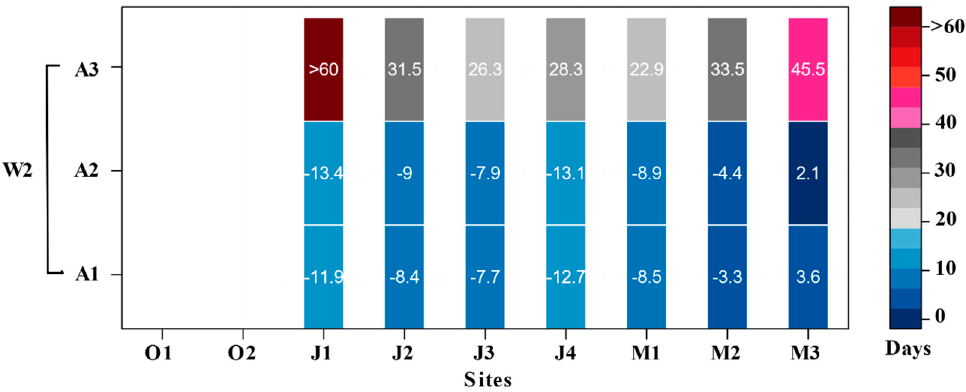
Figure 5. Observed versus simulated timing of the disappearance of the snowpack (days) for algorithms 1 to 3. Negative and positive values indicate anticipation and lag, respectively. The colours of the bar denote absolute values.